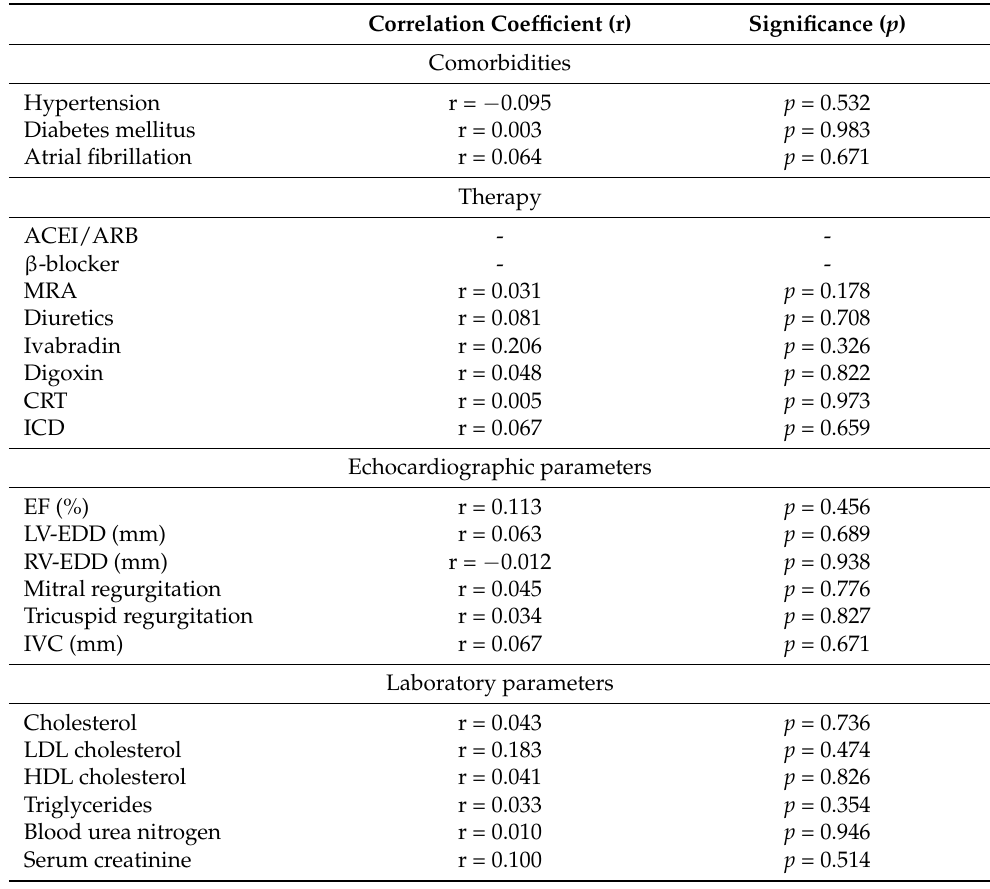
Table 2. Potential influencing factors on plasma PACAP-38 levels. ACEI: angiotensin-converting enzyme inhibitor, ARB: angiotensin-II receptor blocker, MRA: mineralocorticoid receptor antagonist, CRT: cardiac resynchronization therapy, ICD: implantable cardioverter-defibrillator, EF: ejection fraction, LV-EDD: left ventricular end-diastolic diameter, RV-EDD: right ventricular end-diastolic diameter, IVC: inferior vena cava size, LDL: low-density lipoprotein, HDL: high-density lipoprotein. Spearman’s correlation test was